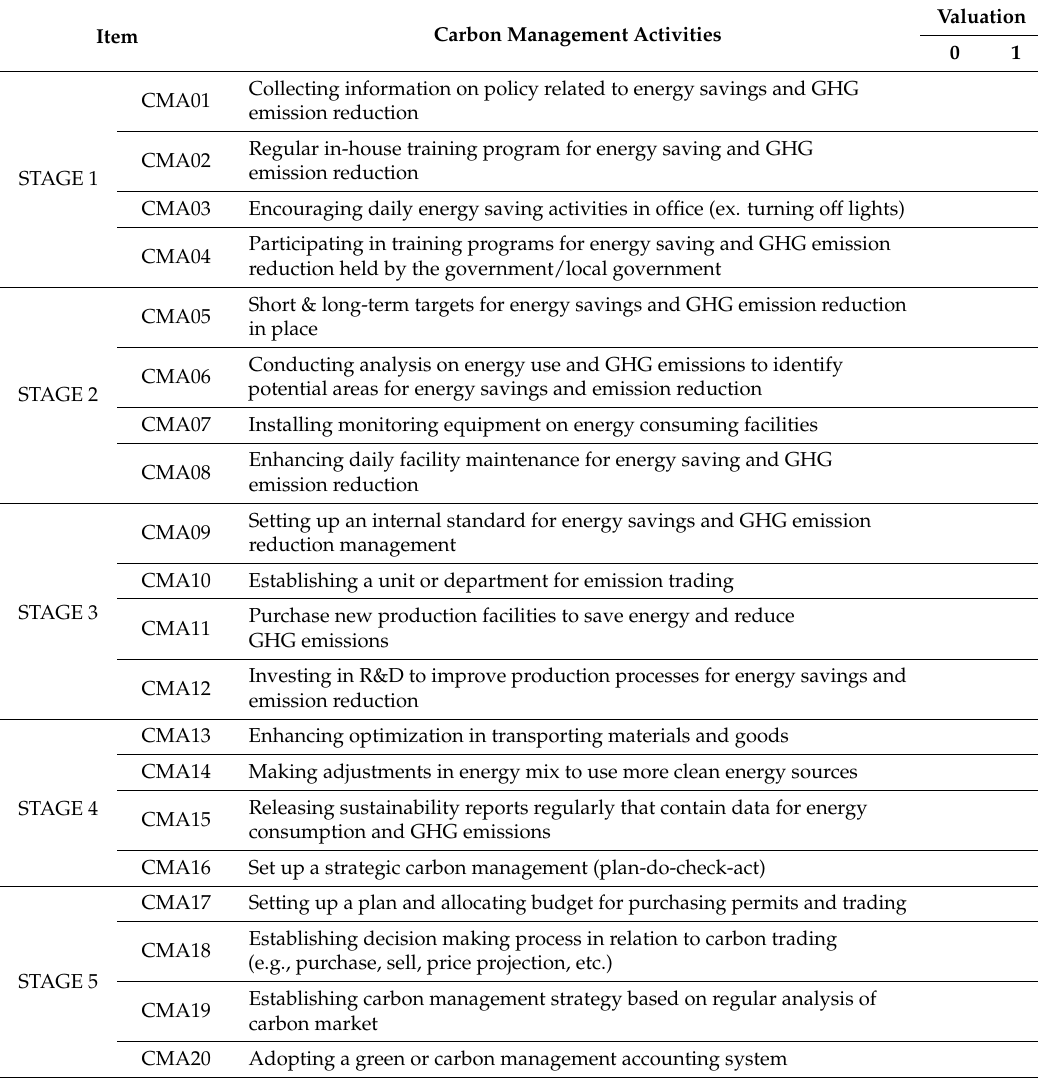
Table 3. Description of CMAs and